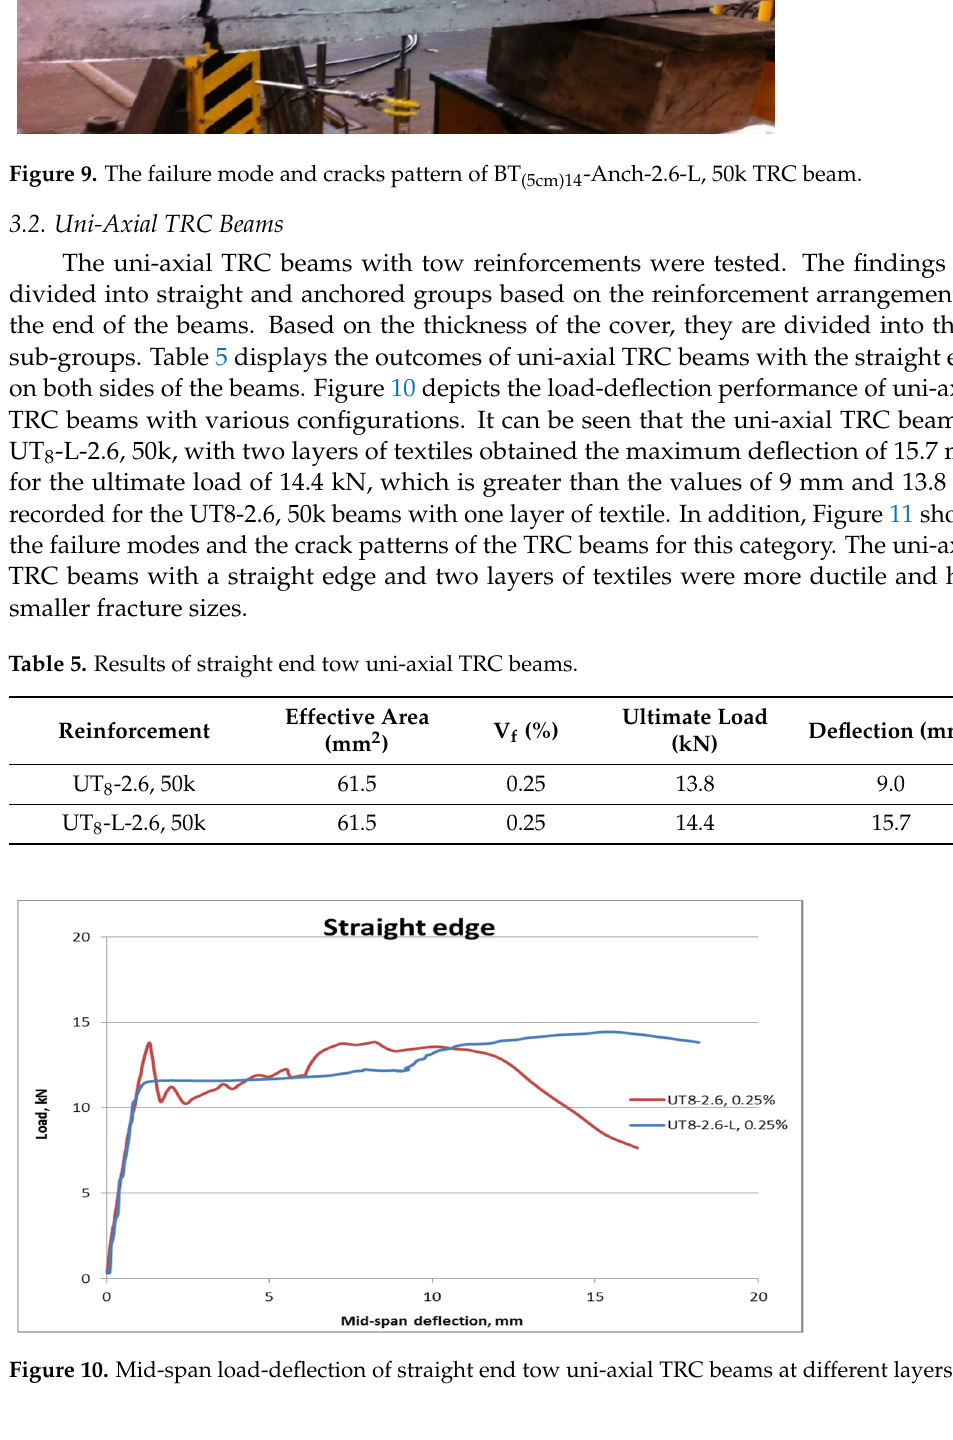
Figure 9. The failure mode and cracks pattern of BT (5cm)14 -Anch-2.6-L, 50k TRC beam.